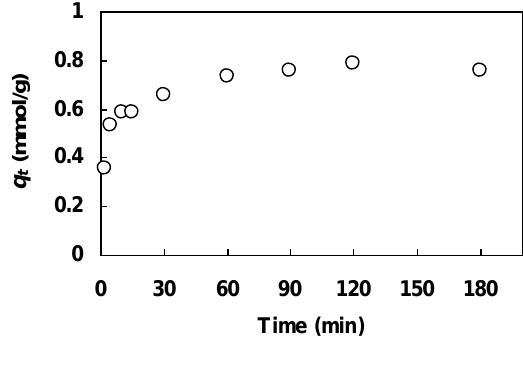
Figure 4. Experimental uptake curve for lead biosorption on orange peels; data of Schiewer and Balaria